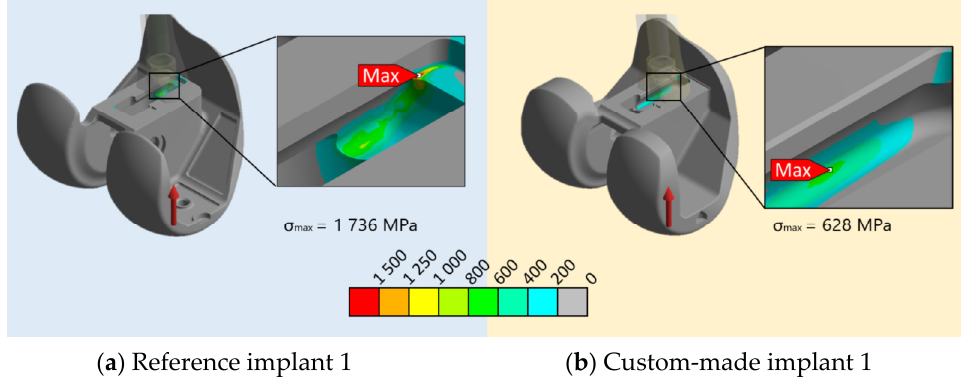
Figure 4. Reference implant 1 and custom-made implant 1. ( a ) Maximum tensile stress (σ max ) and tensile stress distribution of reference implant 1 as well as ( b ) custom-made implant